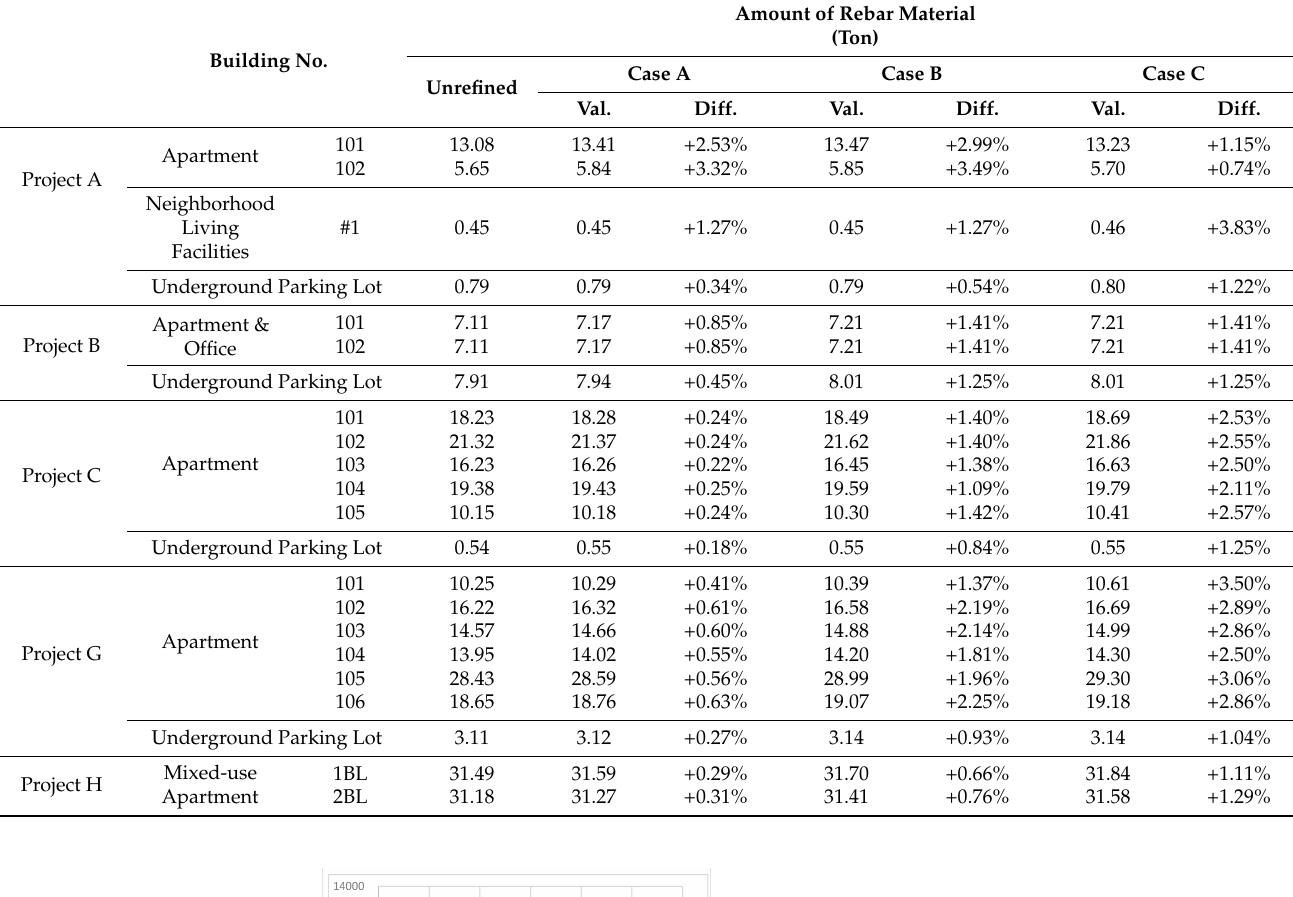
Table A11. Amounts of Rebar Materials for Stairwell Members and Differentials by Cases.